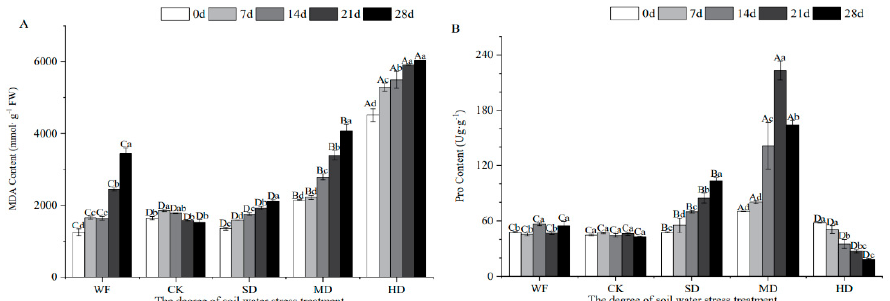
Figure 5. Effects of water stress on malondialdehyde (MDA) content and osmoregulation substances of C. retusus leaves. ( A ) Effects of water stress on MDA content of C. retusus leaves; ( B ) Effects of water stress on Pro content of C. retusus leaves; Upper-case letters represent the variations in different treatment groups, and lower-case letters represent the difference in stress days within the group (significant). See the caption for Figure 1 for an explanation of abbreviations.